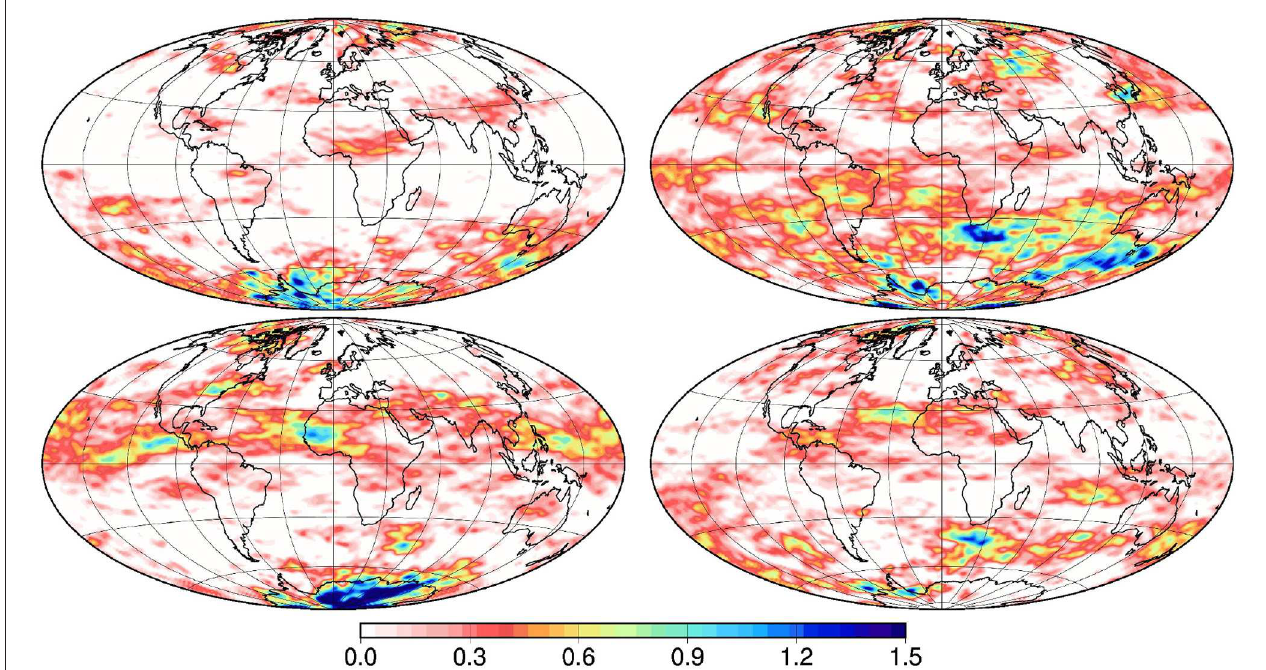
FIGURE 1 | Sample of 4 vectors x from the prior probability